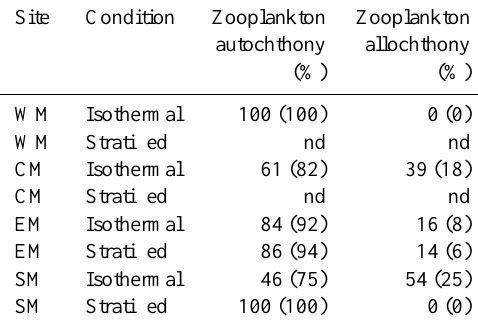
Table 5. Zooplankton allochthony vs. autochthony in Lake Superior based on radiocarbon values of algae (based on DIC) and terrestrial organic carbon (with radiocarbon of atmospheric CO 2 as the ter- restrial endmember). The values in parentheses are estimates when the radiocarbon value of POC from high flow Amity Creek is used as the terrestrial endmember; nd is not determined due to the ab- sence of data (not measured or lost during sample processing) or no feasible solution from the model.